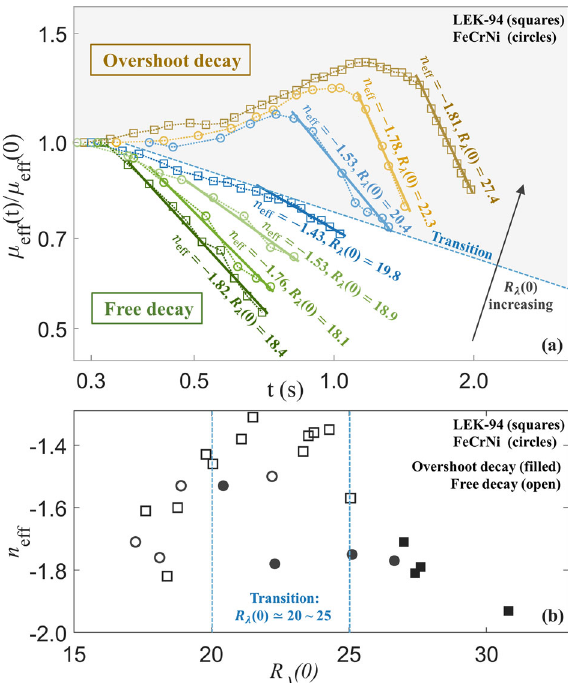
Fig. 4 The decaying effective viscosities and effective decay rates for the overshoot and free decay patterns. a The representative curves of μ eff ( t )/ μ eff (0) on a log-log scale at different R λ (0) along with data fi t (solid lines). b Effective decay rate n eff as a function of R λ (0).